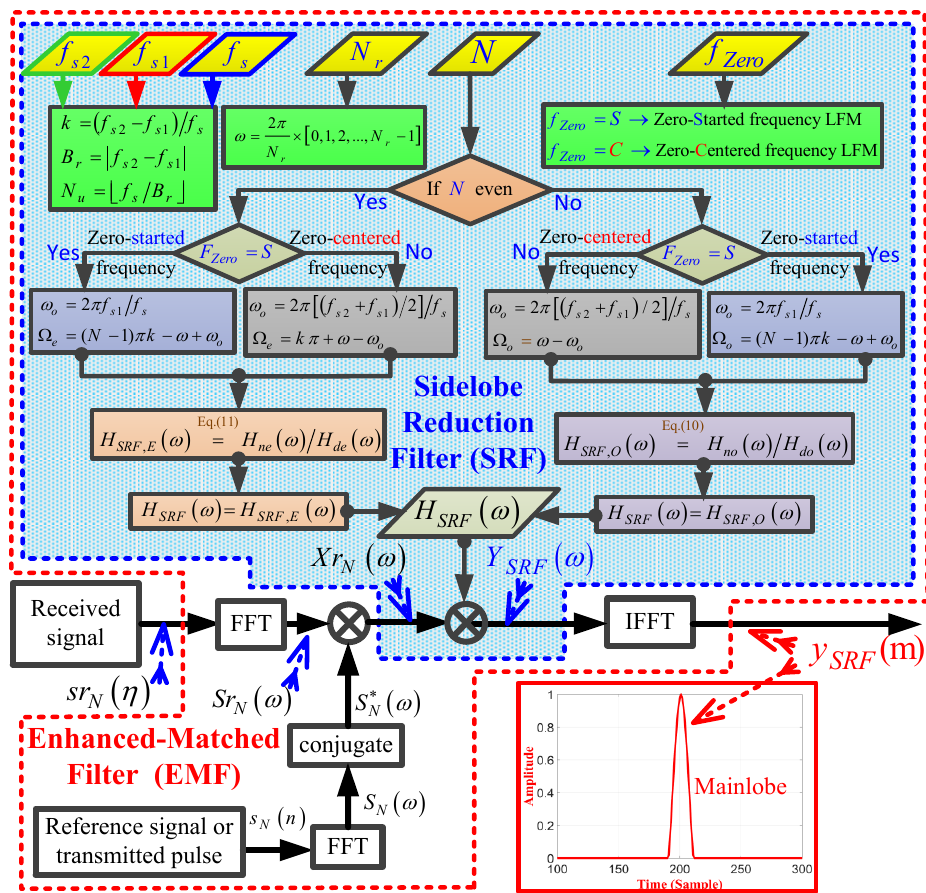
Figure 10. A detailed flowchart of the proposed EMF for an LFM